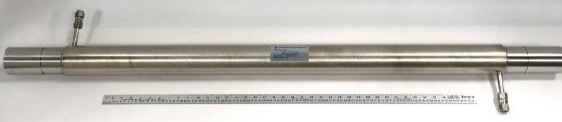
Fig. 1. A water-cooled stainless steel corrugated waveguide for